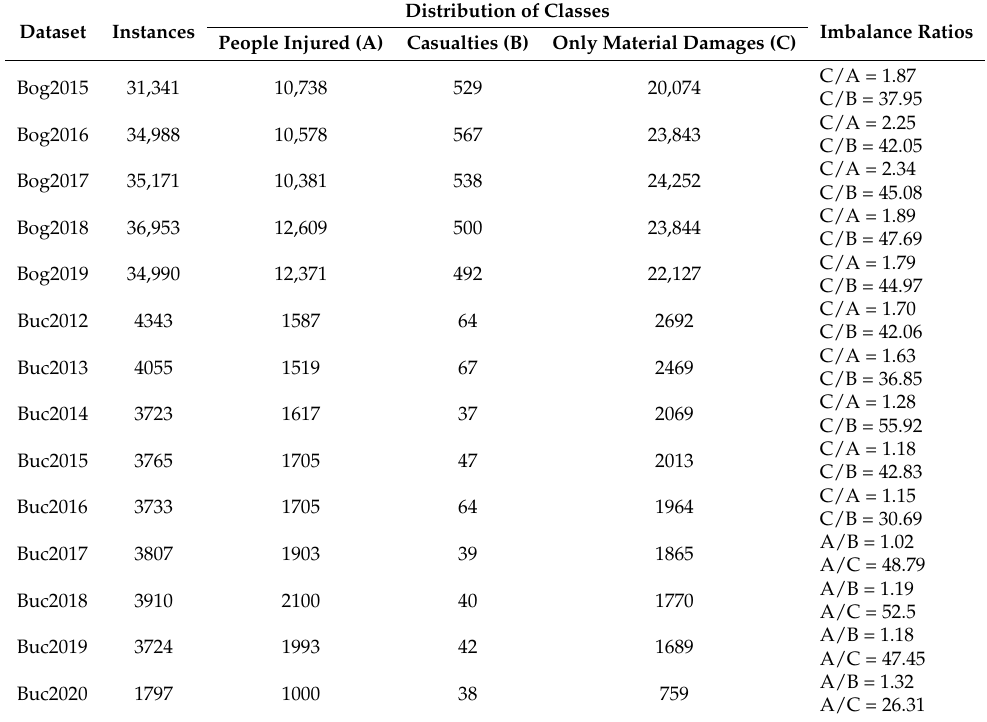
Table 7. Bogotá (Bog) and Bucaramanga (Buc) case studies: Description of Multiclass datasets.